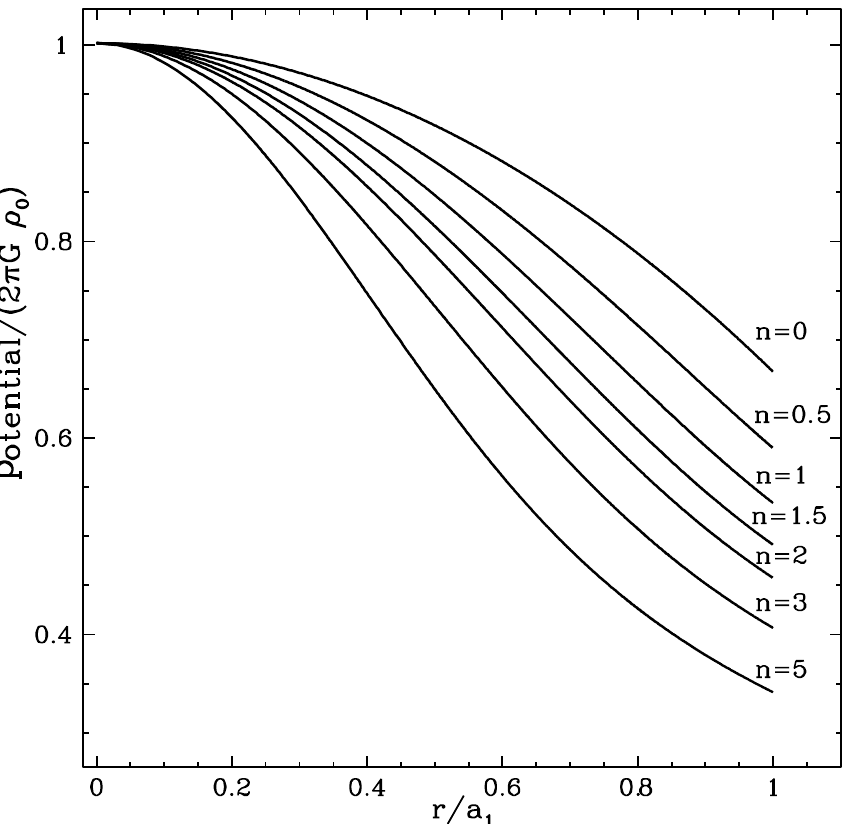
Fig. 1. Internal potential in the equatorial plane of a spheroid. The seven curves from top to bottom represent the potentials computed for different n in the ascending order ; 1 ; 3 ; 2 ; 3 ; 5 this parameter: n = 0 ; 1 2 2